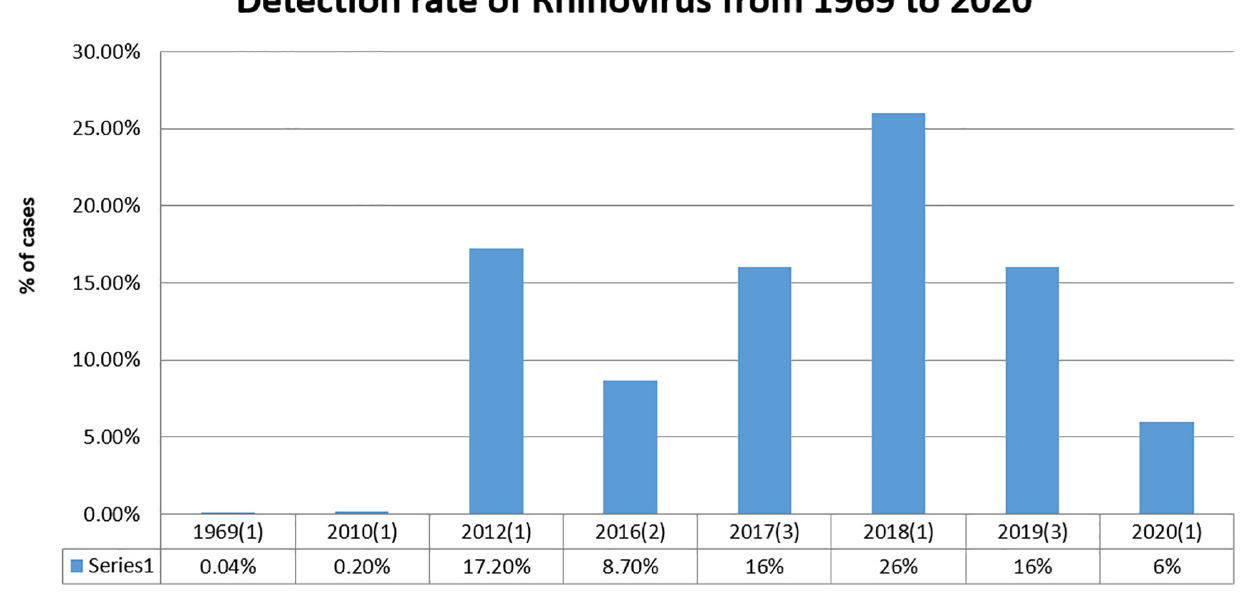
FIGURE 3 | Detection rate of rhinovirus from 1964 to 2020. The number of reports included in the study during this period is indicated in